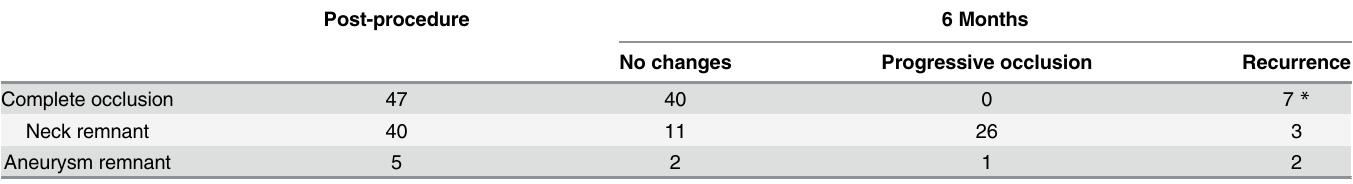
Table 3. DSA results at six months (n =